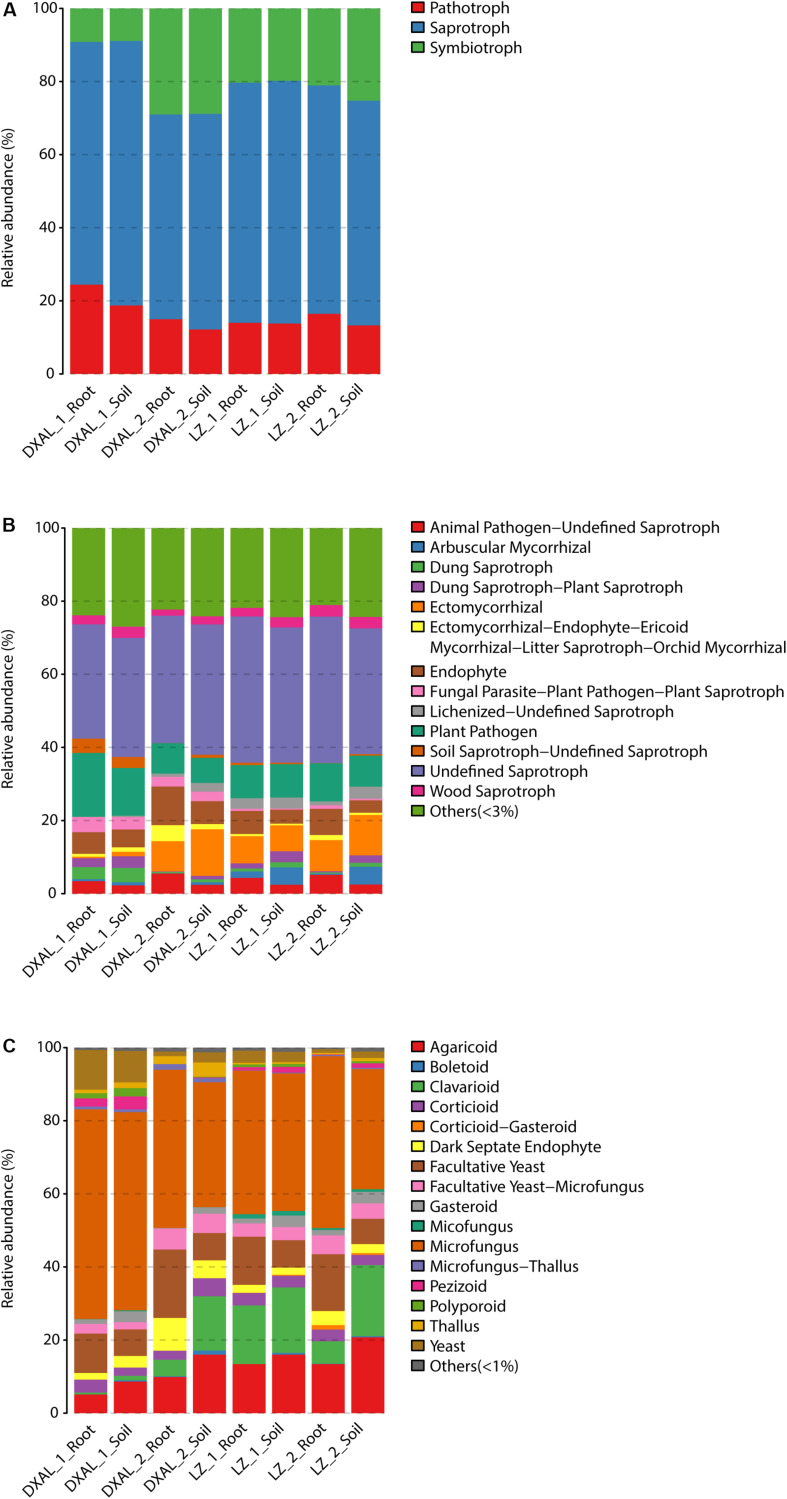
Compositions of fungal functional group (guild) inferred by FUNGuild. (A) At the trophic mode level. (B) At guilds level. (C) At Growth_Morphology level. DXAL: Greater Khingan Mountains, LZ: Linzhi, 1: vegetative growth stage, 2: reproductive growth stage.